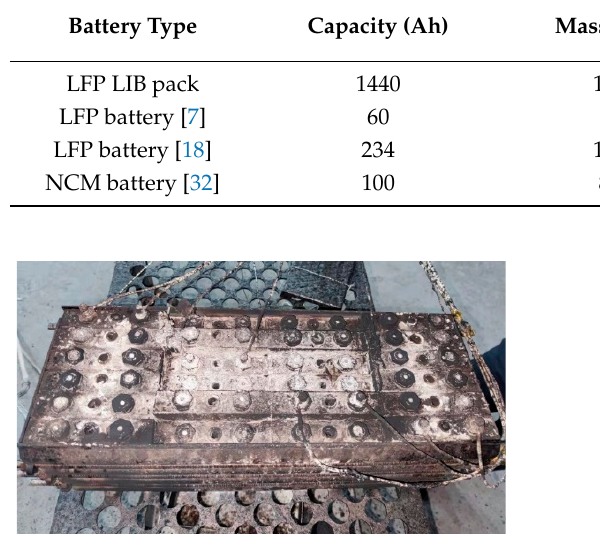
Table 1. Mass loss after the TR process.